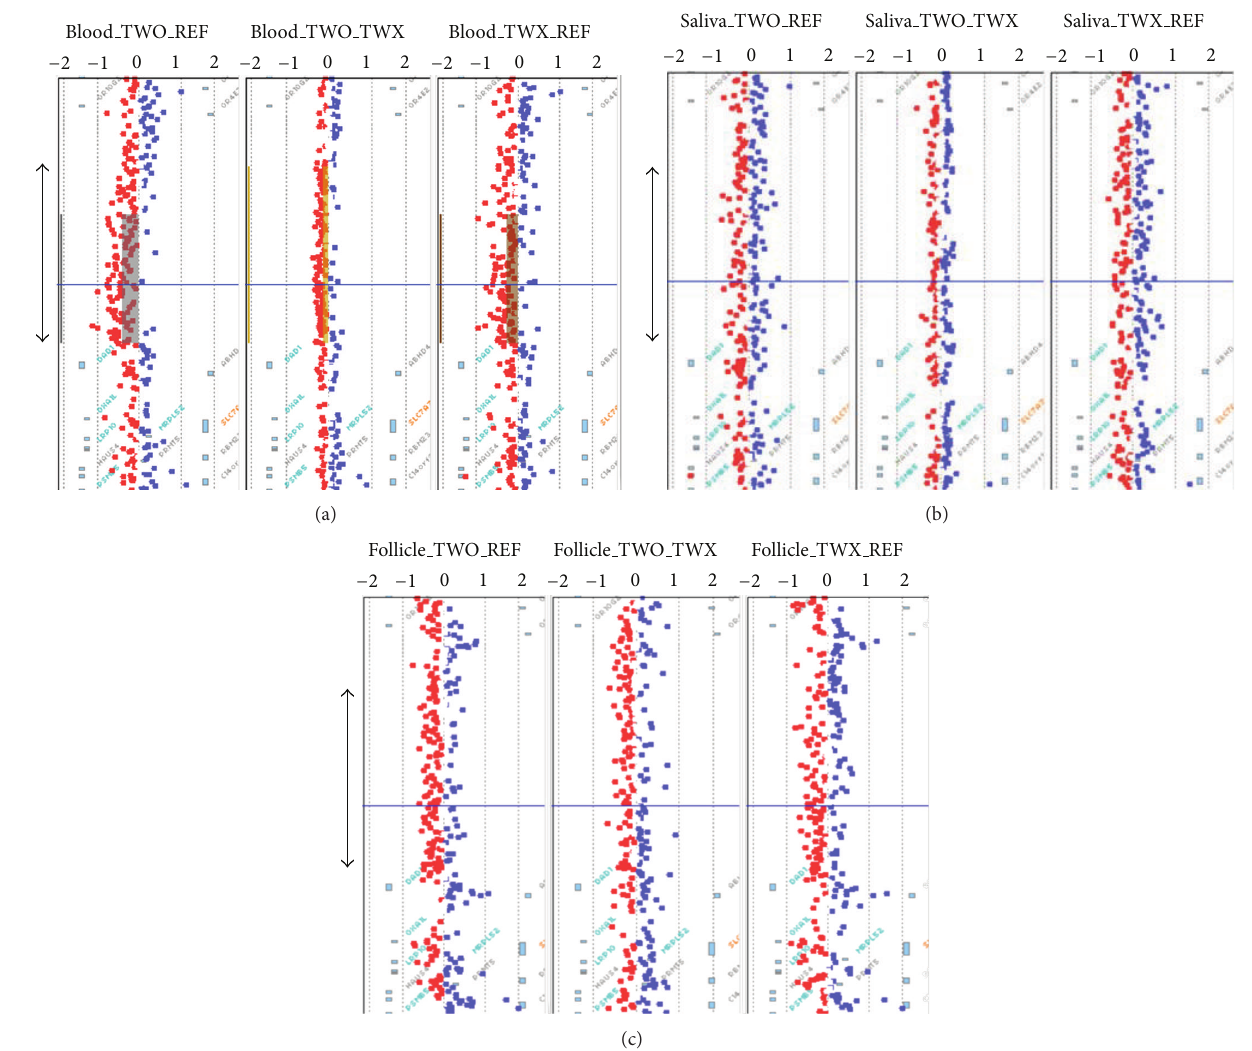
Figure 2: Screenshot of Agilent CytoGenomics softwarecorresponding to chr14:22000000-23500000 region. (a) Blood, (b)saliva, and (c)hair follicle. On each panel (left to right) we present the CGH results from TWO-to-reference, twin-to-twin, and TWX-to-reference, respectively. Double arrows delimit the T-cell receptor alpha locus